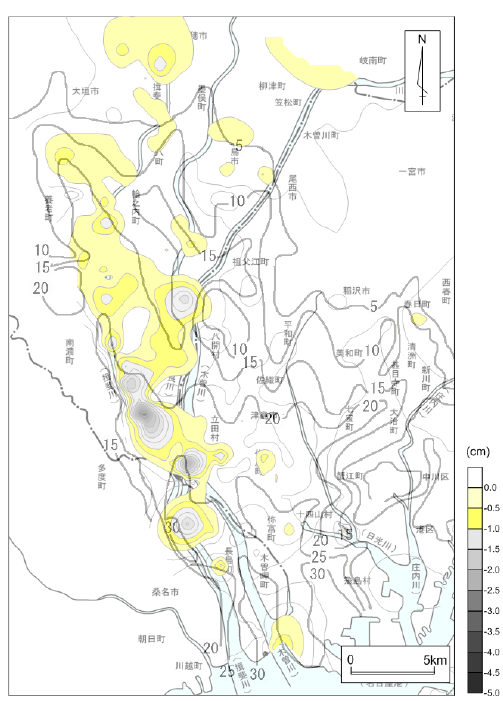
Figure 2. Cumulative land subsidence amount in the Nobi Plain (1976–1988).